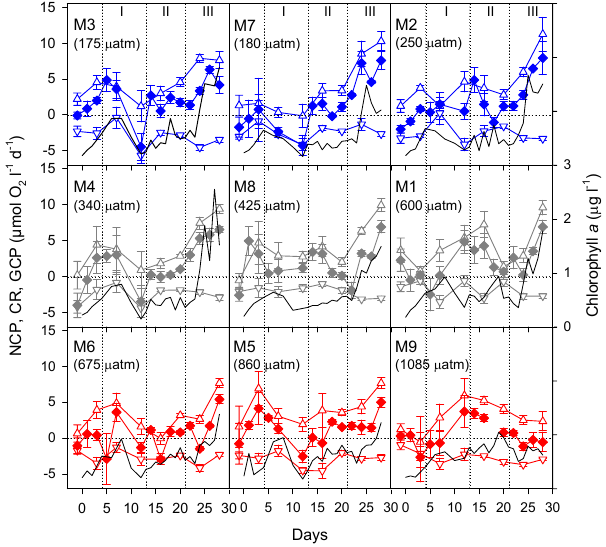
Fig. 1. Temporal changes of gross community production (GCP: open upside triangle), net community production (NCP: filled di- amond), and community respiration (CR: open downside triangle) based on changes of dissolved oxygen during incubation. Values are mean ± standard error (µmol O 2 L − 1 d − 1 ) . The color code is as follows: blue for low p CO 2 treatments (M3, M7, and M2), grey for intermediate p CO 2 treatments (M4, M8, and M1) and red for high p CO 2 treatments (M6, M5, and M9). Black solid lines are HPLC- based chlorophyll a concentration (µgL − 1 : Schulz et al., 2012). Vertical dotted lines separate phases 1, 2, and 3 during the exper- iment (see also the text). p CO 2 values (µatm) denote the mean dur- ing the experiment (Bellerby et al., 2012).